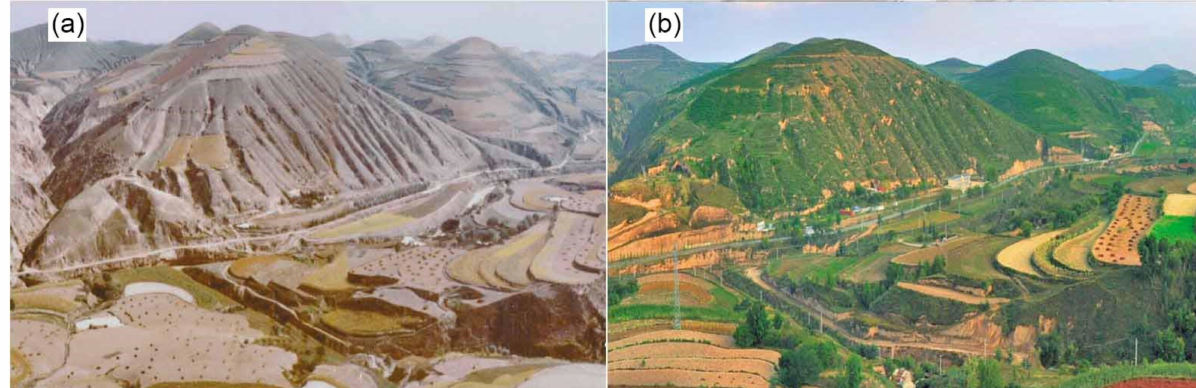
Figure 10. Comparison before and after the policy of GGP in LPC. ( a ) before GCP (1984) in Wuqi County, Shaanxi Province; ( b ) after GCP (2017) in Wuqi County, Shaanxi